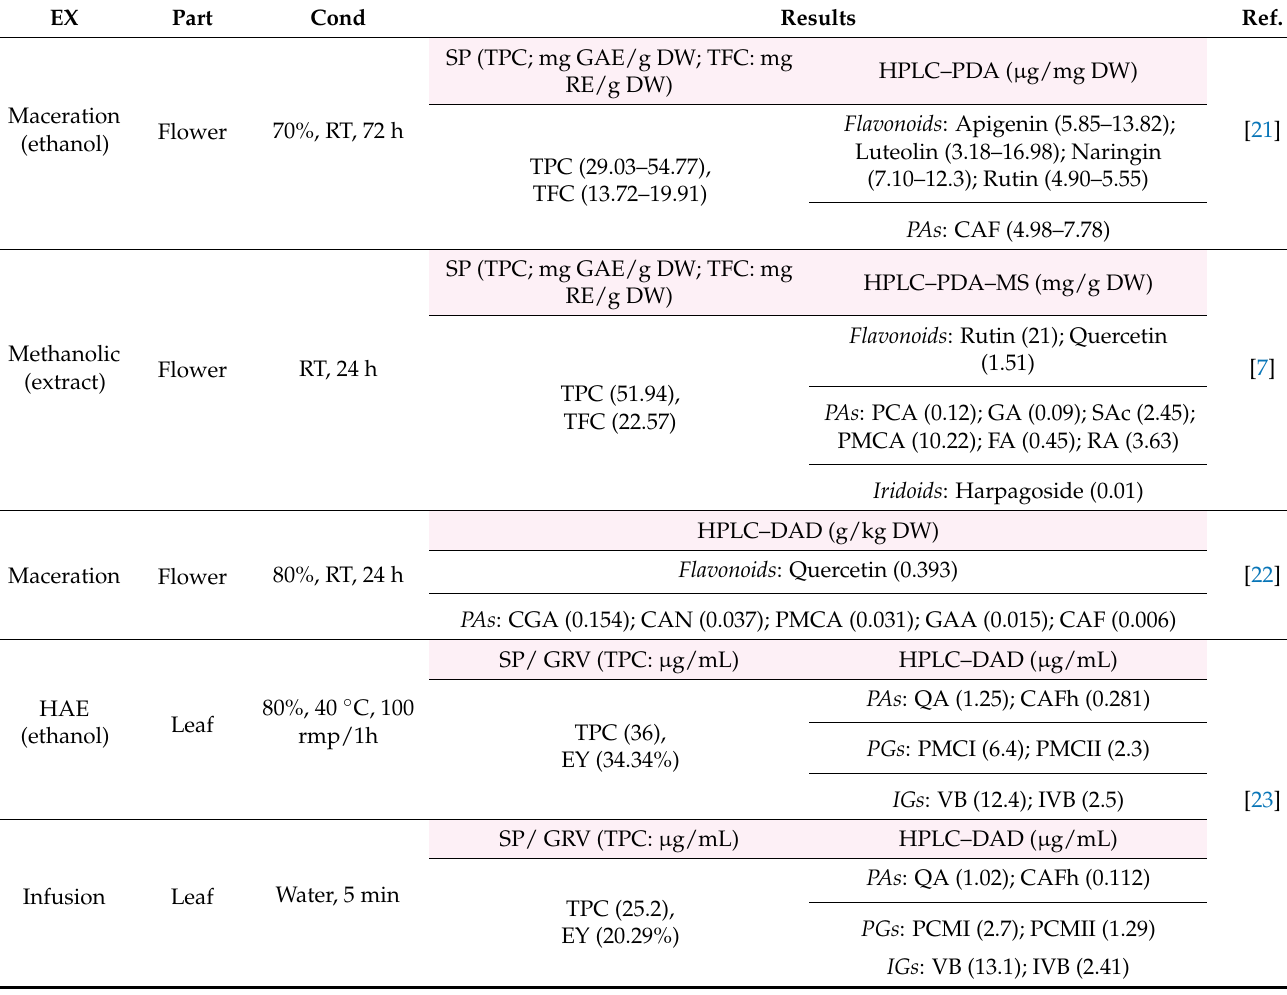
Table 2. Studies on the bioactive composition of V. sinuatum